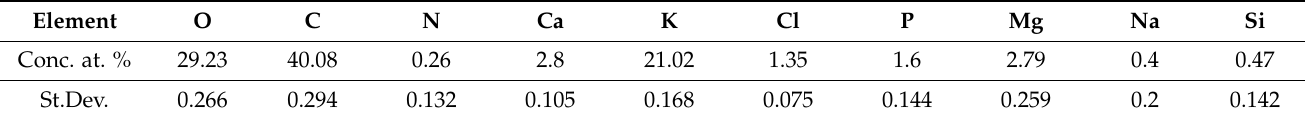
Table 7. Composition of the hogweed ash (in at %) determined from XPS.